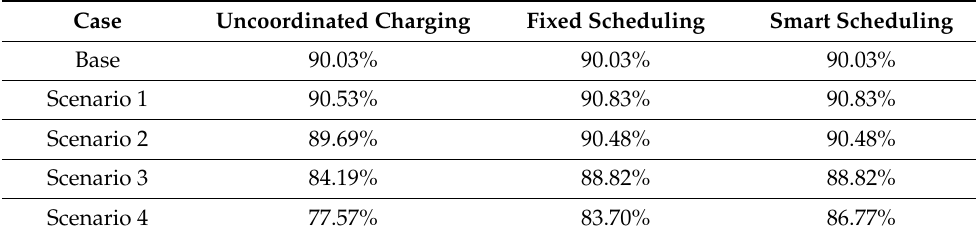
Table 5. Load factor